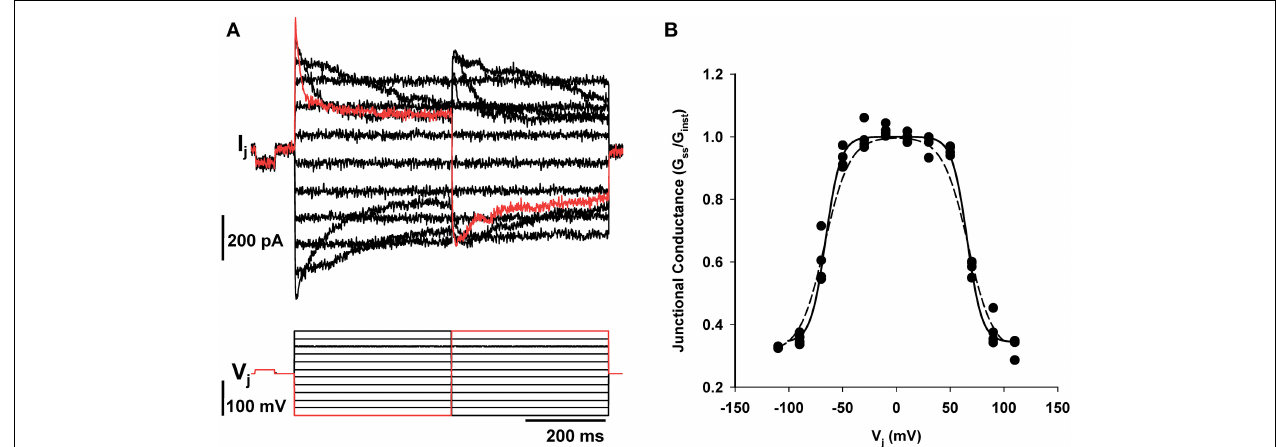
FIGURE 3 | Dual whole cell patch clamp of corpora cell pair. (A) Junctional currents recorded in one cell of a pair generated in response to voltage steps in the other. Upper records are junctional current, lower record shows the voltage steps. (B) Steady state junctional conductance (G ss /G Ins t ) plotted against transjunctional voltage step as previously described (Wang et al.,